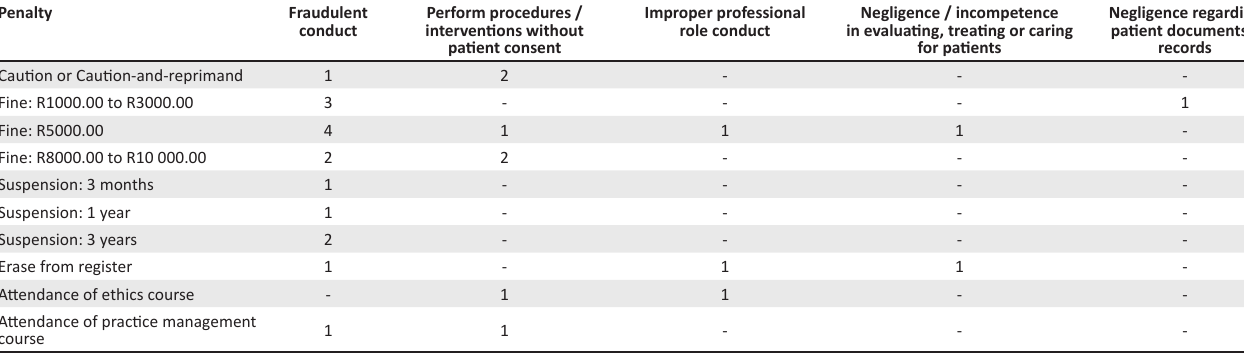
TABLE 3: Frequency of penalties imposed on transgression categories. Penalty